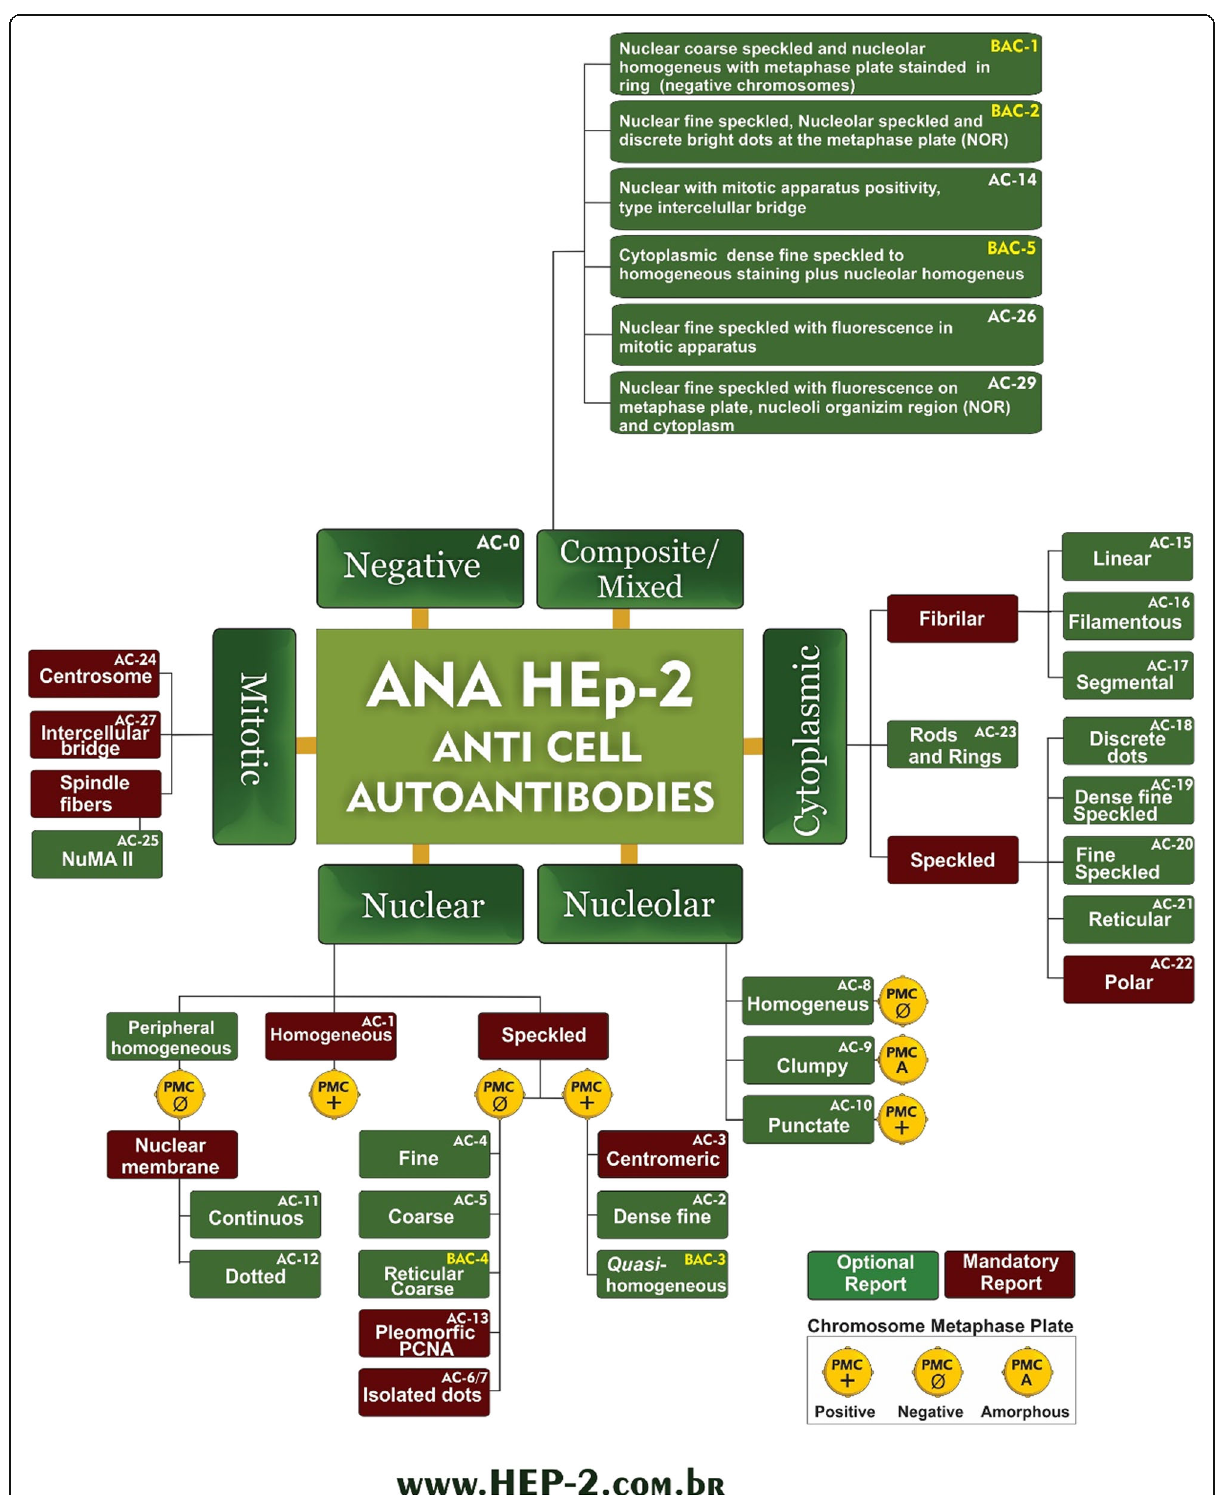
Fig. 2 V Brazilian Consensus for Autoantibodies on HEp-2 cells, classification